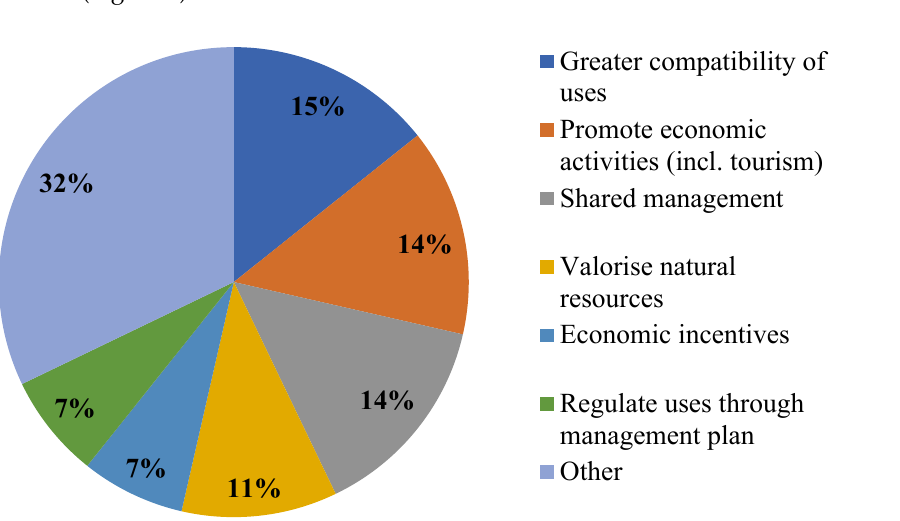
Figure 7. Experts’ actions to improve depopulation figures in protected municipalities to be imple- mented by protected areas’ administrations.